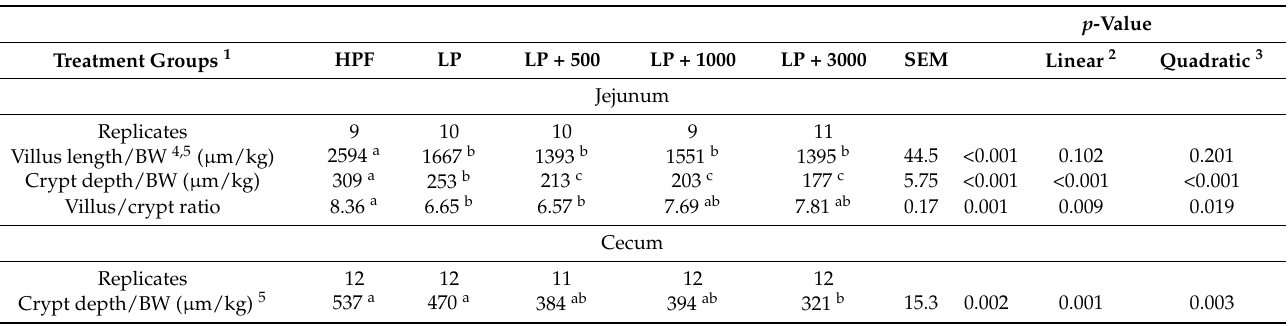
Table 5. Effect of different inclusion levels of phytase on morphometry in jejunum and cecum of broiler chickens at 21 days of age.